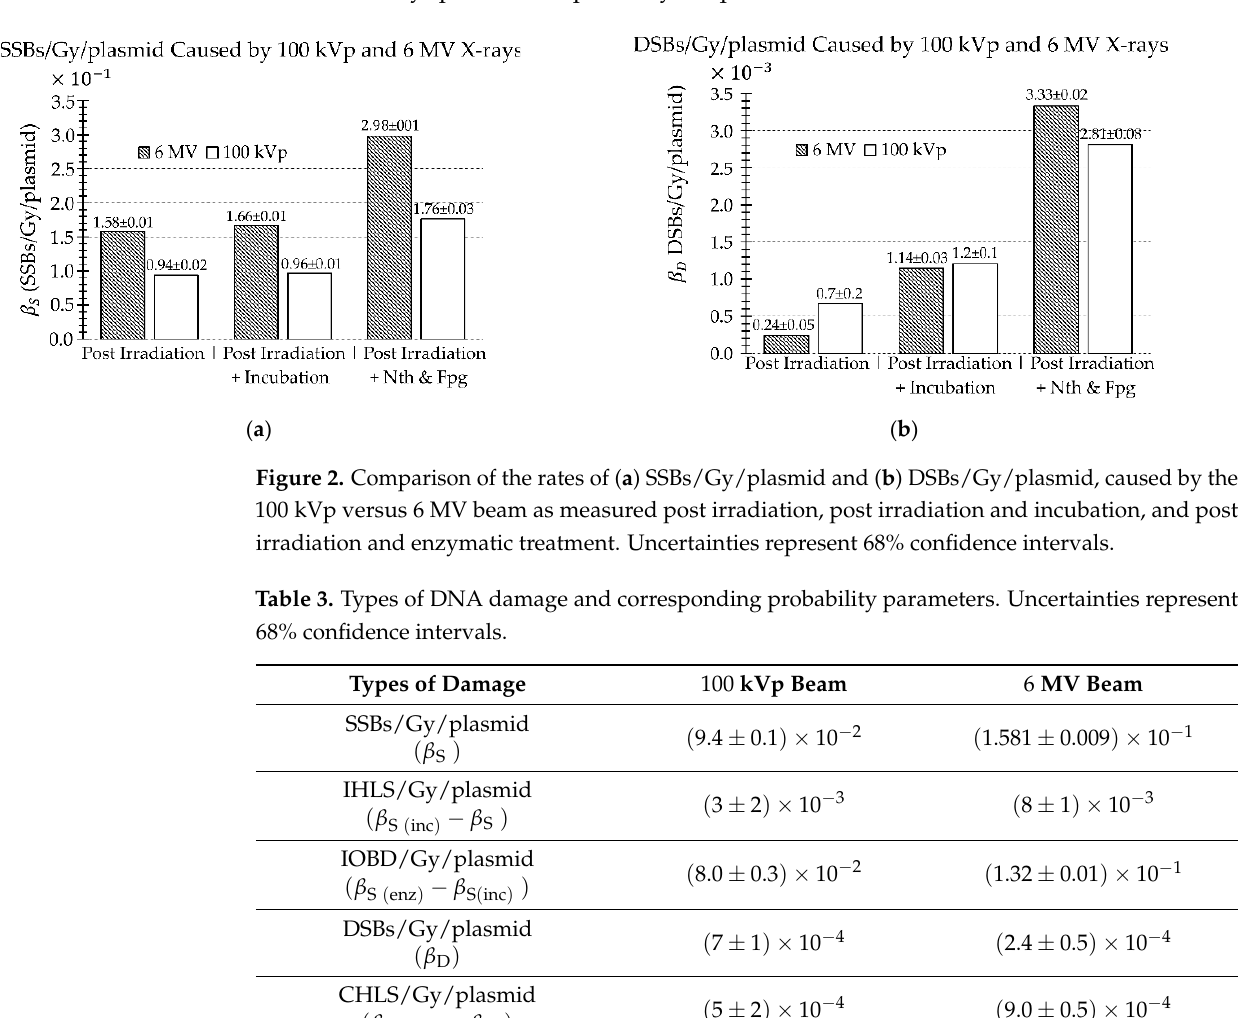
(cid:16) (cid:17) β ( inc ) , and